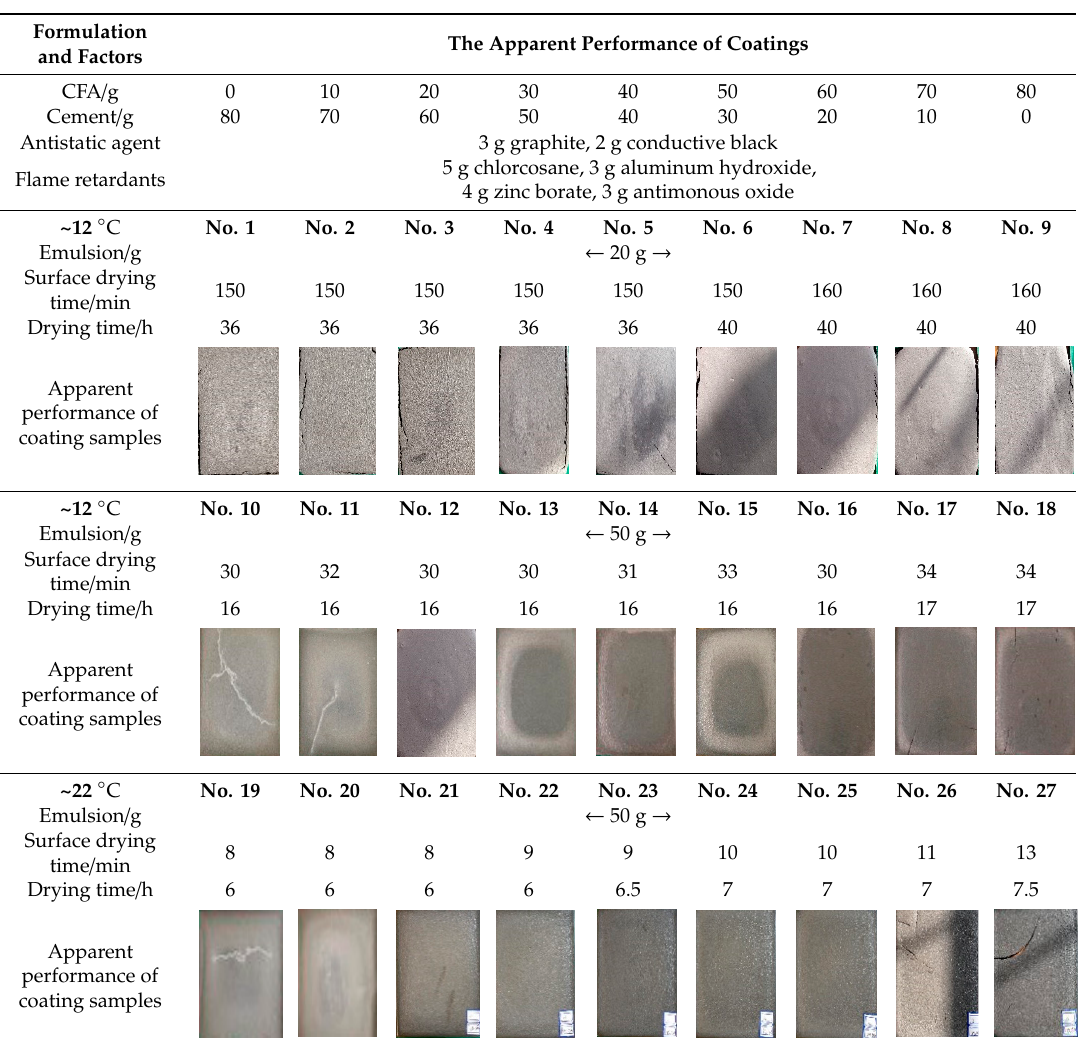
Table 2. Effect of different factors on apparent performance of coatings. (Factors: ratio of emulsion to powder, temperature, dosage of CFA).